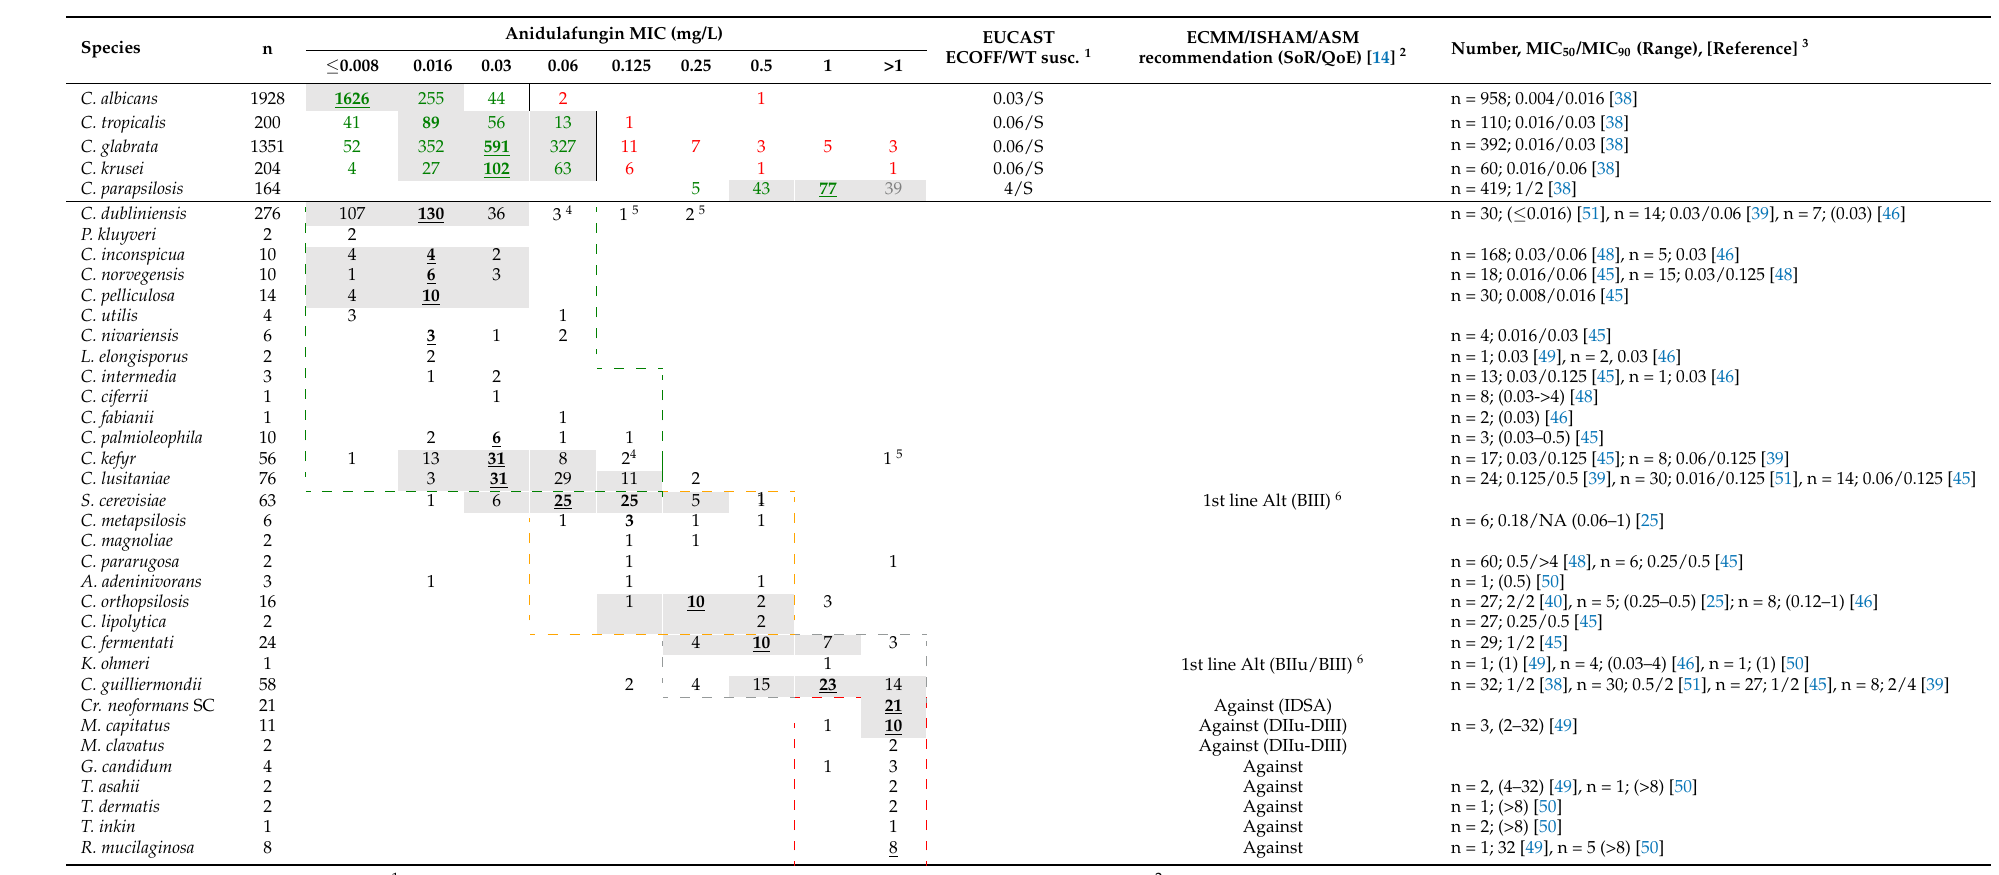
Table 5. Anidulafungin EUCAST MICs against Danish common and rare yeast species sorted by increasing MICs. The coloured boxes indicate the intrinsic relative susceptibility (S (green)/I (orange)/R (red)/Unkown (grey)) of wild-type isolates of a given